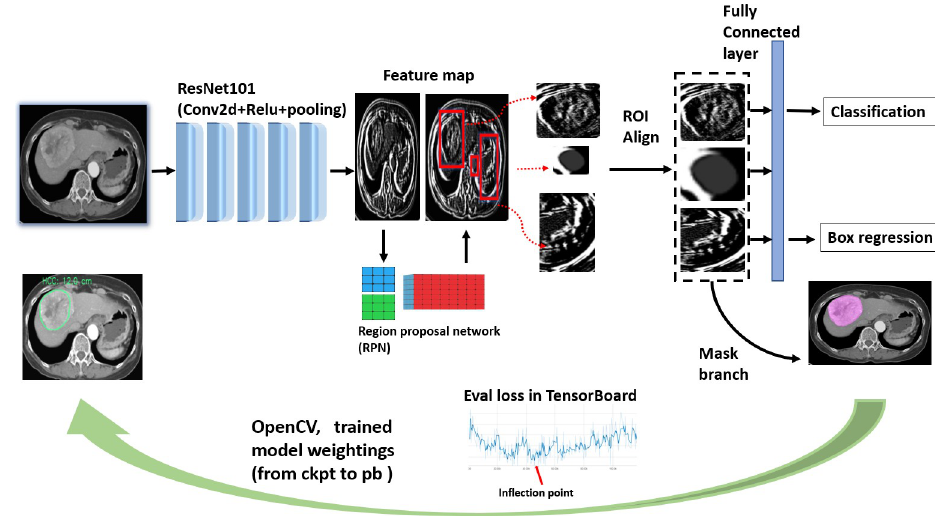
Fig 5. Diagram of mask R-CNN modeling and inference